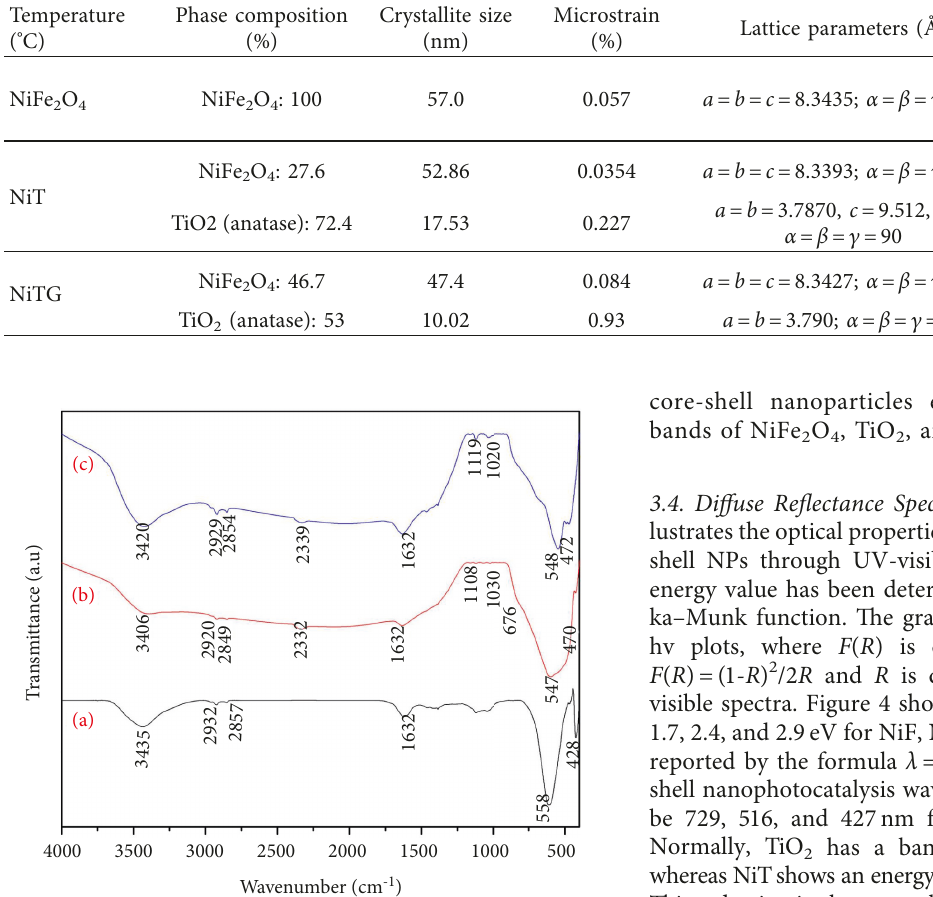
Figure 3: FTIR patterns of (a) NiFe